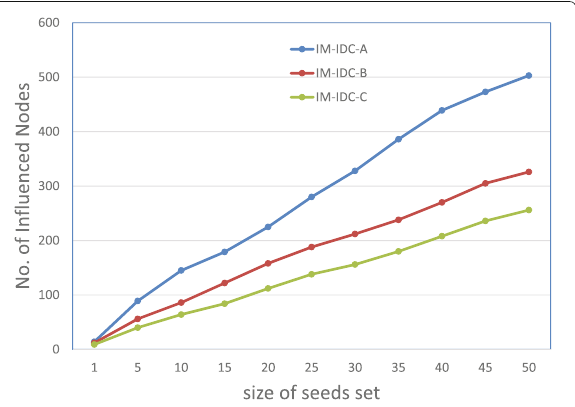
Fig. 6 The No. of influence set size on LiveJournal data while increasing the size of seed nodes, where IM-IDC-A, IM-IDC-B, and IM-IDC-C are A PPRO IM-IDC with low , medium , and high Poisson distribution parameters